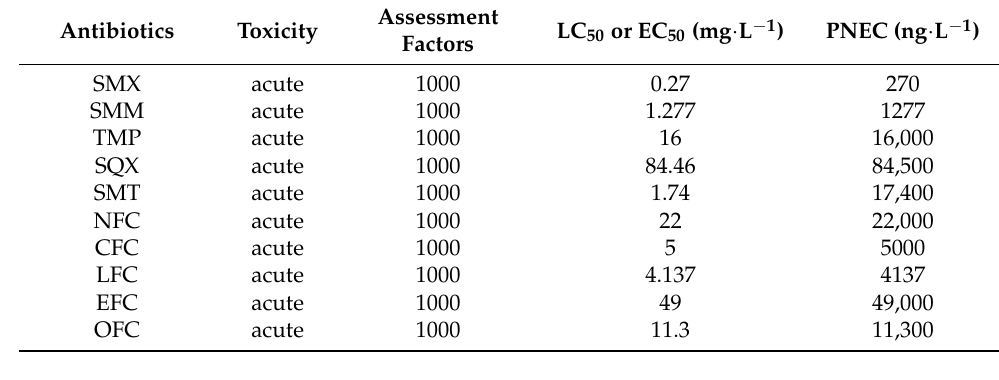
Table 6. Aquatic toxicity data of antibiotics [3-5].